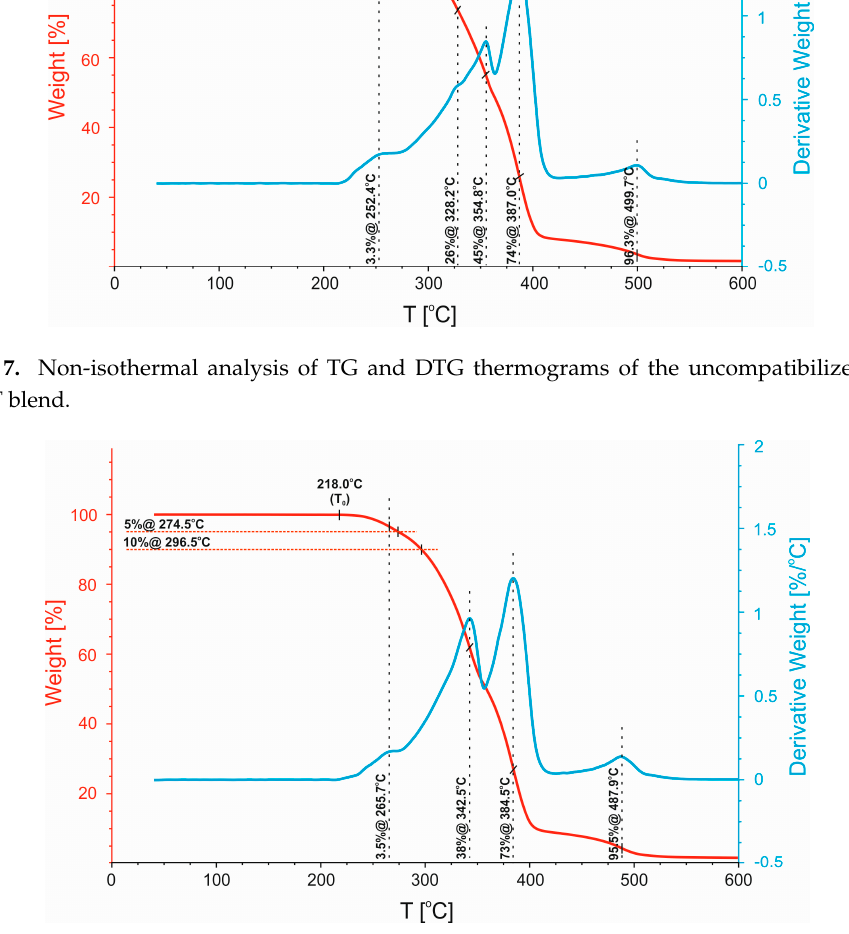
Figure 9. Non-isothermal analysis of TG and DTG thermograms of 50/50 PP/PBT blend containing SEBS copolymer. Table 4. Thermal decomposition temperatures of 50/50 PP/PBT blends. Polymer Blend